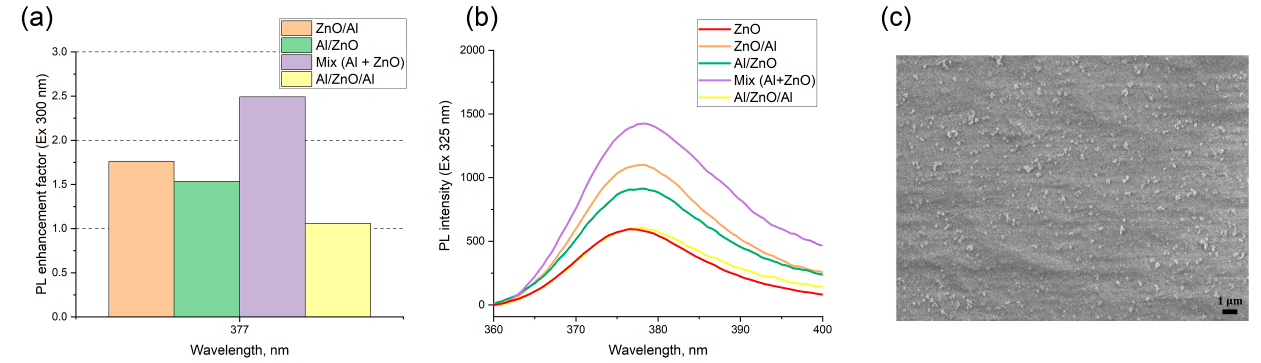
Figure 4. Photoluminescent properties of film nanostructures based on Al and ZnO NPs: ( a ) De- pendence of PL enhancement factor at an excitation wavelength of 300 nm for samples with different combinations of layers; ( b ) Luminescence spectra at an excitation wavelength of 325 nm